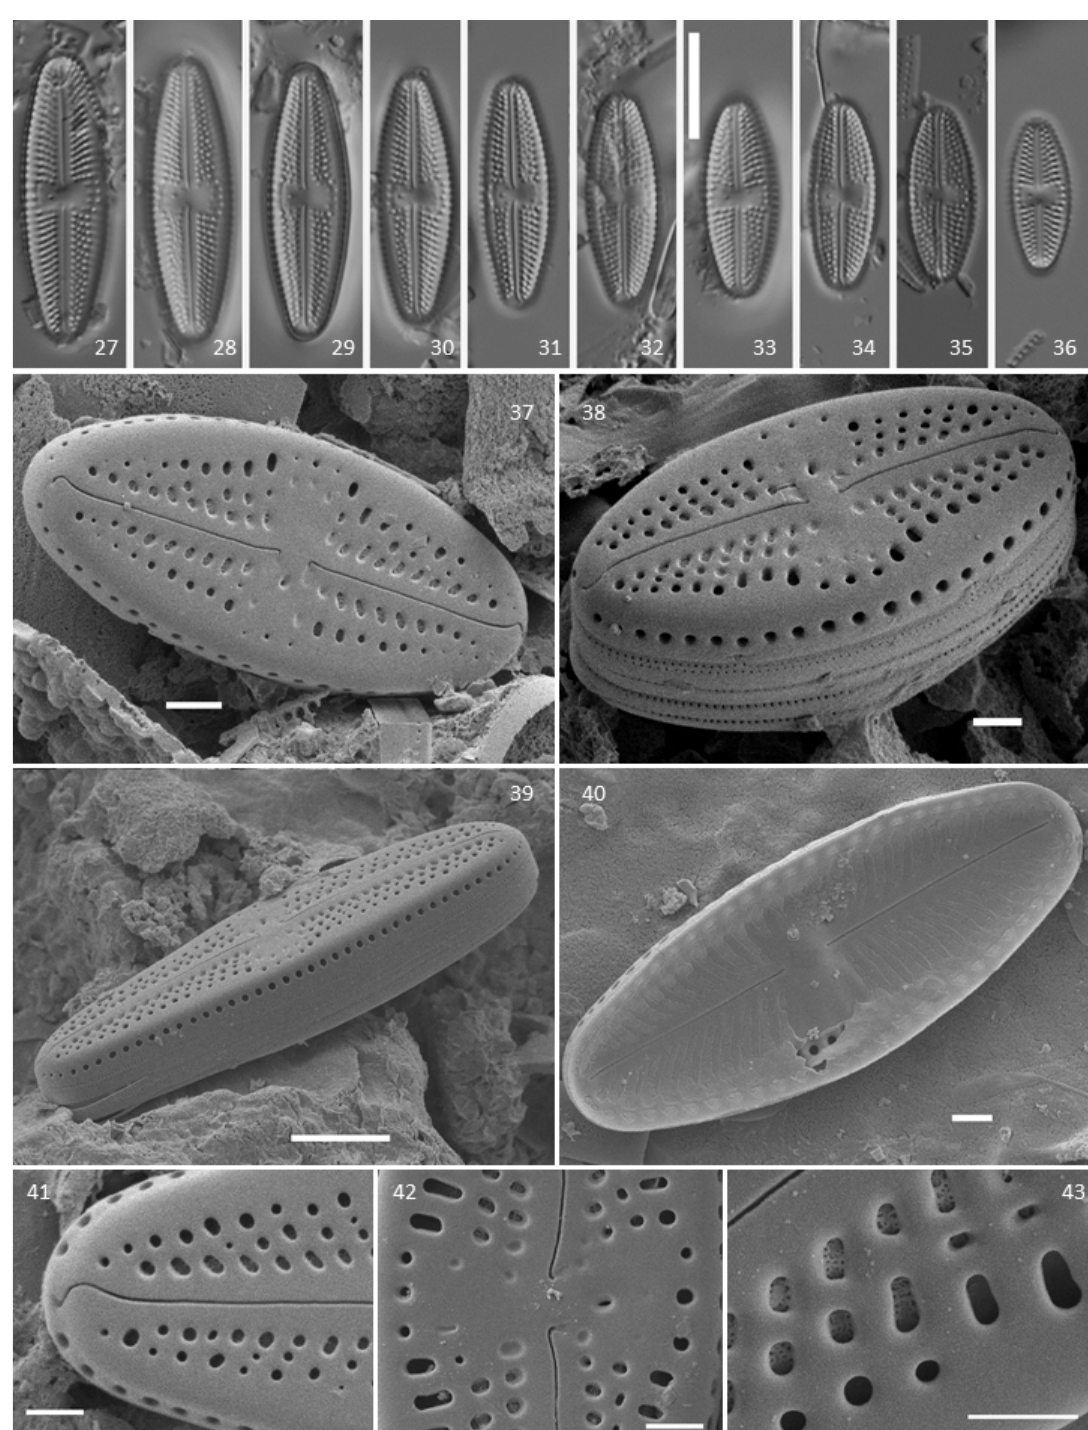
Figs 27–43. Luticola ivetana Chattová & Van de Vijver sp. nov. Light (LM) and scanning electron micrographs (SEM) from the type population from Entrecasteaux on Ile Amsterdam, B. Van de Vijver sample W030 . 27–36 . LM of valve face views. 37–38 . SEM of valve exterior. 39 . SEM girdle view. 40 . SEM of valve interior. 41 . SEM of external detail of hooked terminal raphe fissures. 42 . SEM of external detail view of central area showing the typical deflection of proximal raphe endings. 43 . SEM of external detail view of areolae structure. Scale bars: 27–36 = 10 µm; 37–38, 40–43 = 1 µm; 39 = 5